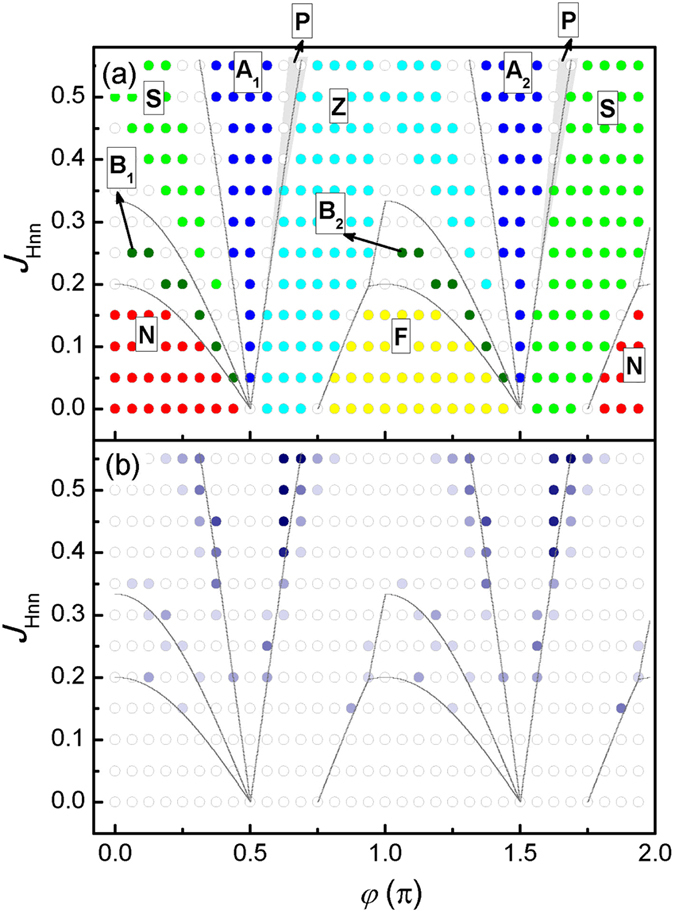
(a) The phase diagram, where the gray curves give the phase borders calculated from classic energy comparison. The solid circles filled with different colors show different phases identified by correlations obtained from simulation, and those empty circles represent the unidentified regions. The light gray regions schematically present the area of P phase. (b) The diagram of the fluctuation of local energy (FLE), where the shading of filled-circles refers to the value of FLE with white representing the minimum FLE = 0.